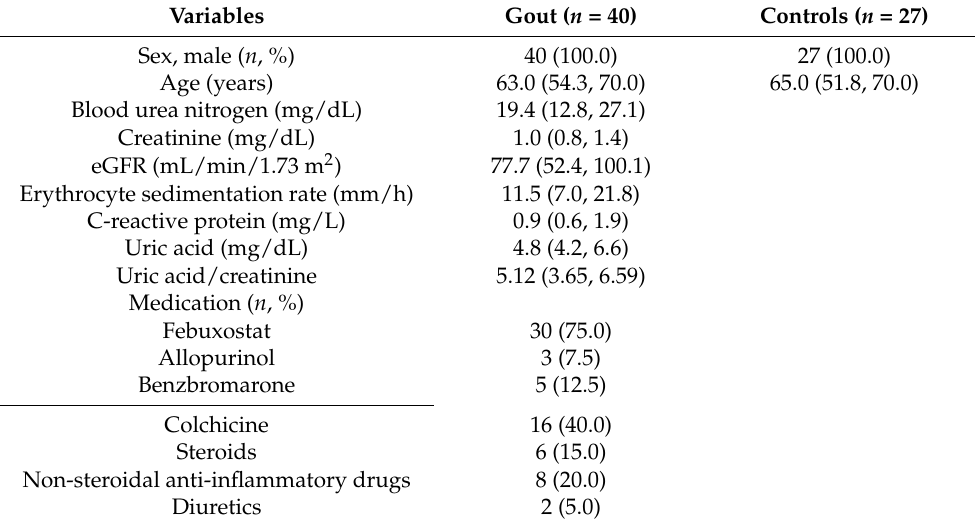
Table 1. Baseline characteristics of the study